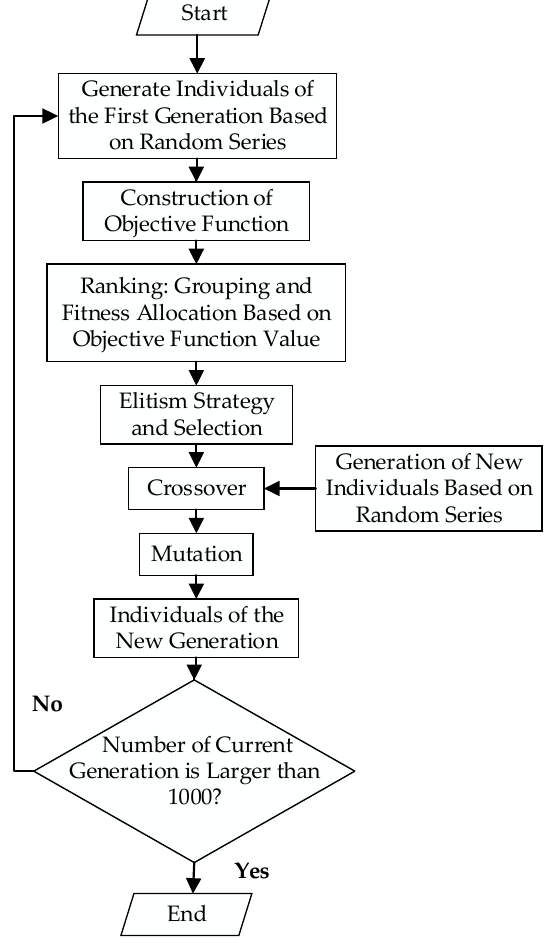
Figure 4. Flow chart of multiobjective genetic algorithm.